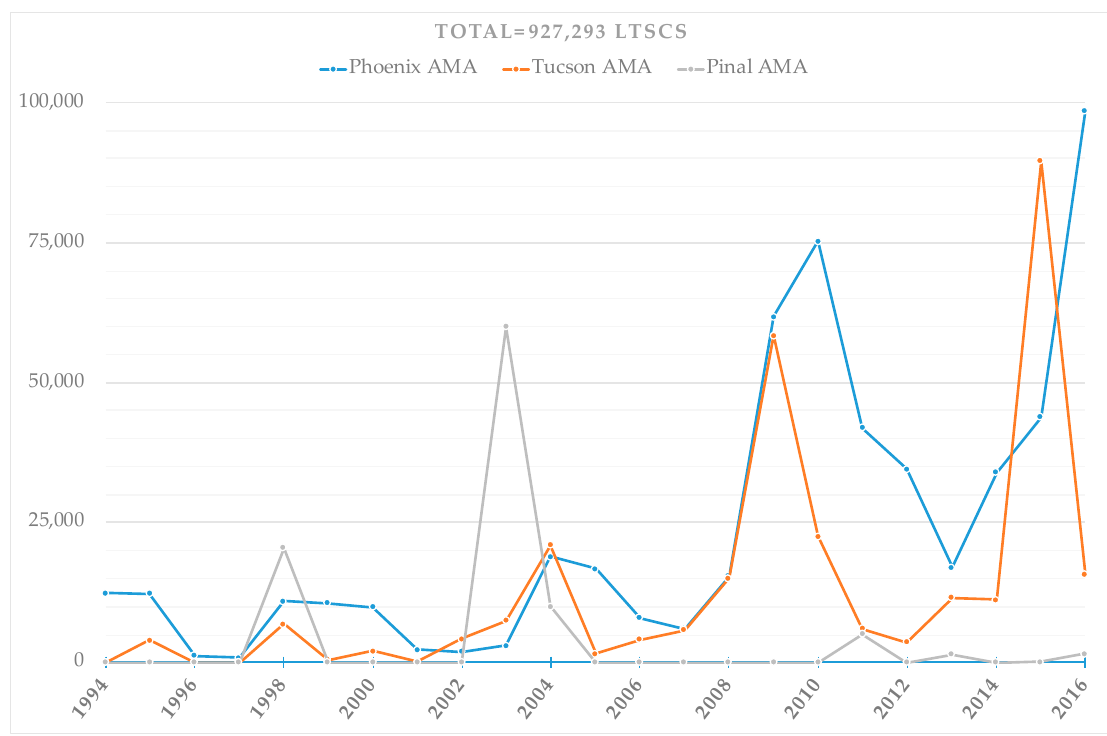
Figure 3. Volume of long-term storage credits sold in Central Arizona AMAs, from 1994 to 2016.